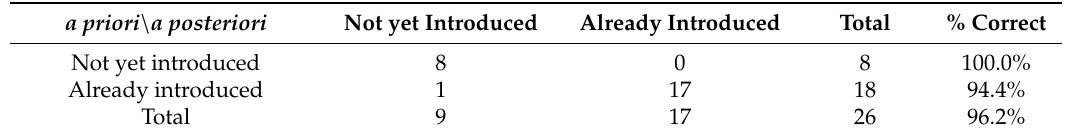
Table 6. Confusion matrix for factorial discriminant analysis of two categories of bark and ambrosia beetles according to their past introduction into new areas.